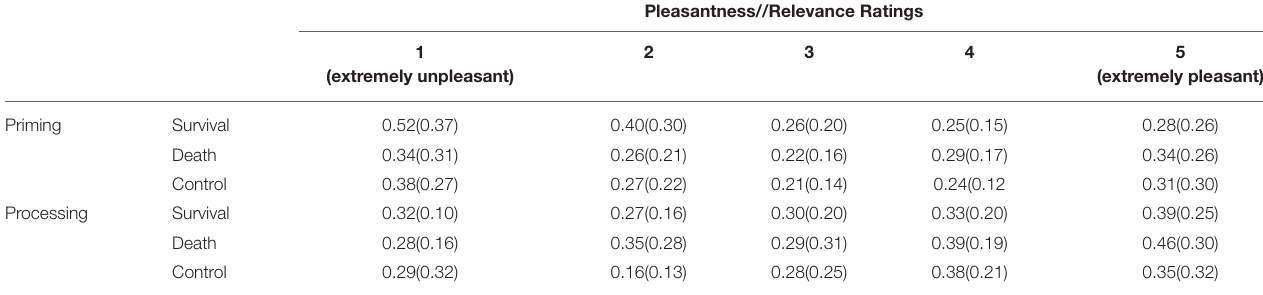
TABLE 3 | Mean proportions of words recalled as a function of experimental condition and pleasantness/relevance rating in Experiment